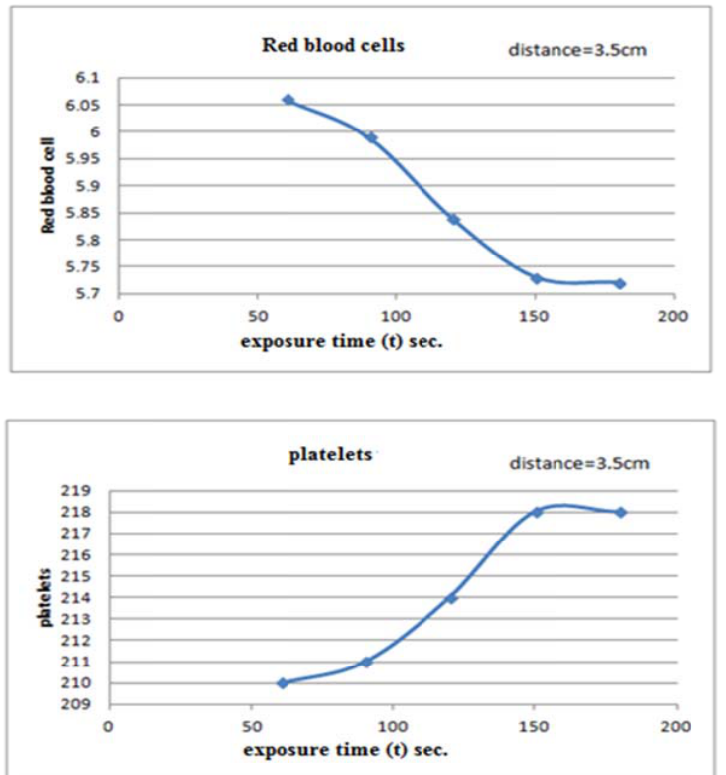
red blood ce ells and plate elets at dista ance 2.5cm.